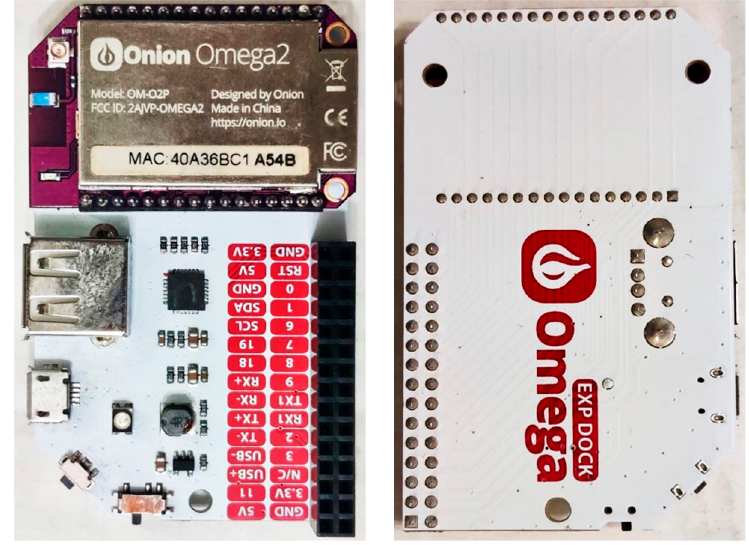
Figure 1. Omega2 hardware [9].